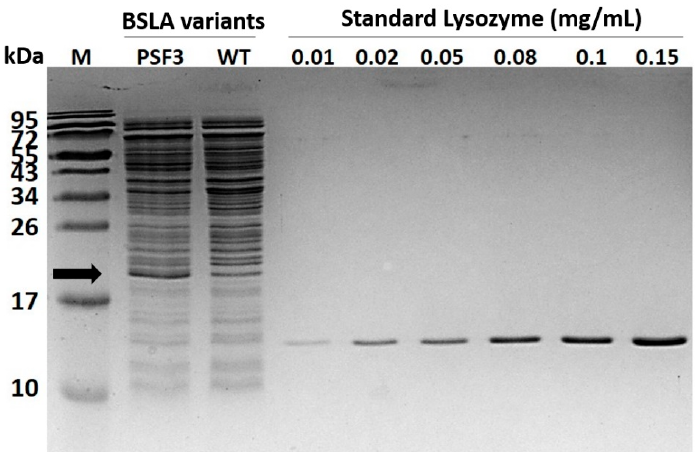
Figure A3. SDS-PAGE of concentrated samples of variant P5F3 and wildtype BSLA. The concentration of BSLA and P5F3 in a 10 kDa mini crossflow concentrated cell supernatant (VivaFlow 200, Sartorius), was estimated through image-based analysis and relative quantitation using a lysozyme calibration curve (Biorad ImageLab). The result was 59.7 µ g / mL for P5F3 and 23.0 µ g / mL for wildtype